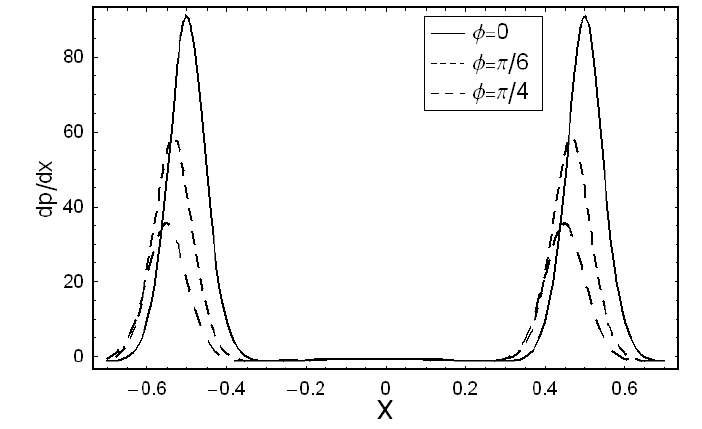
Figure 3. Variation in dp / dx for φ with a = 1.0, b = 0.7, d = 1.2, n = 1.5, b ∗ = 0.2 and Θ =